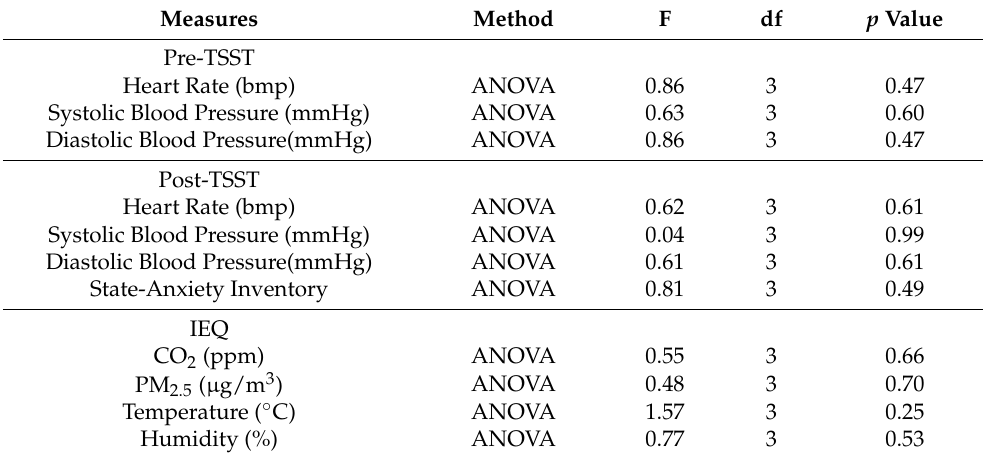
Table 2. Test on whether participants’ physical data and psychological data at baseline (pre-TSST), post-TSST and IEQ among four environments were similar or not.